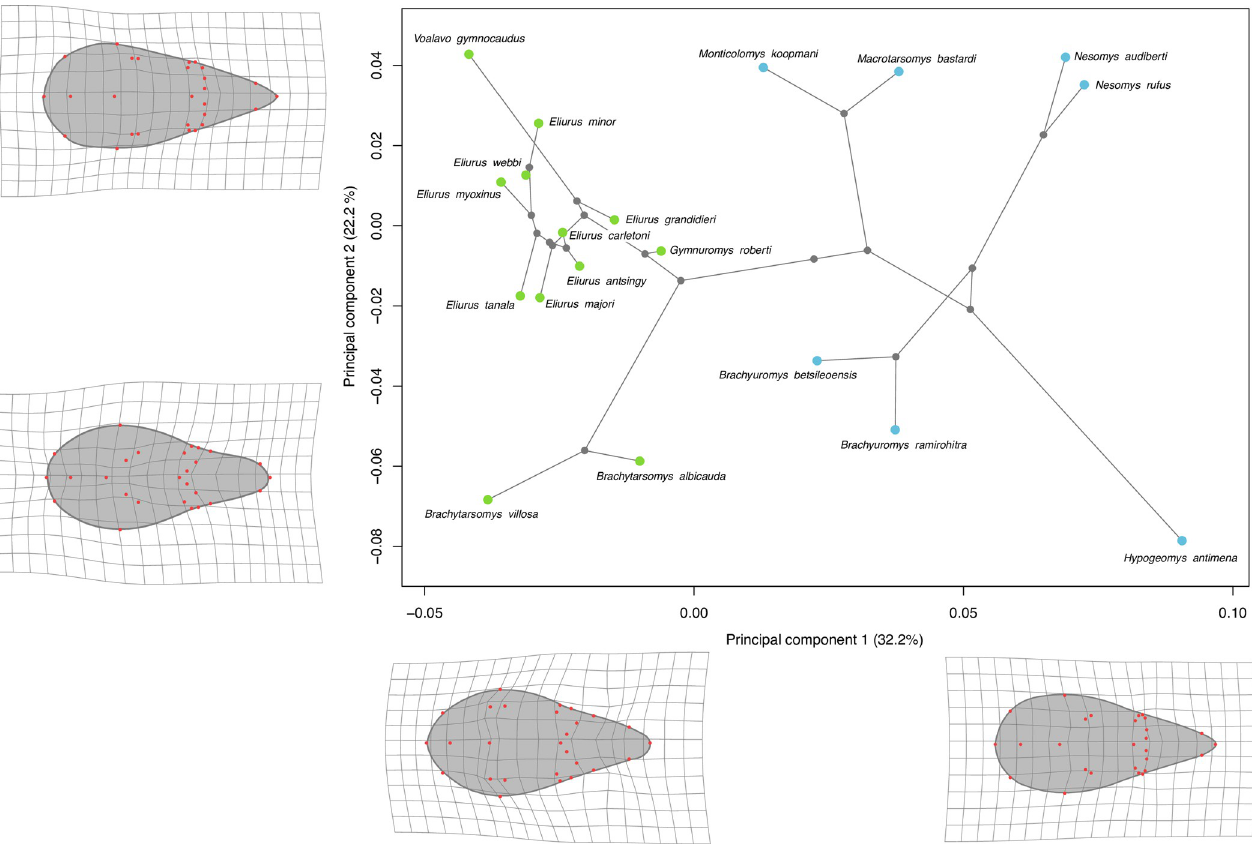
Fig 2. Visualization of the two first axes of the PCA performed on dorsal shape with phylogenetic projection. Colored points represent the morphological average of all individuals of a species. Colors indicate the two principal clades among Nesomyinae. Blue: clade formed by the genus Brachyuromys , Nesomys , Macrotarsomys , Monticolomys , and Hypogeomys ; green: clade formed by the genus Brachytarsomys , Eliurus , Gymnuromys , and Voalavo . Warpgrids indicate shape variation along axis with maximum deformation observed at each extremity of the axis.